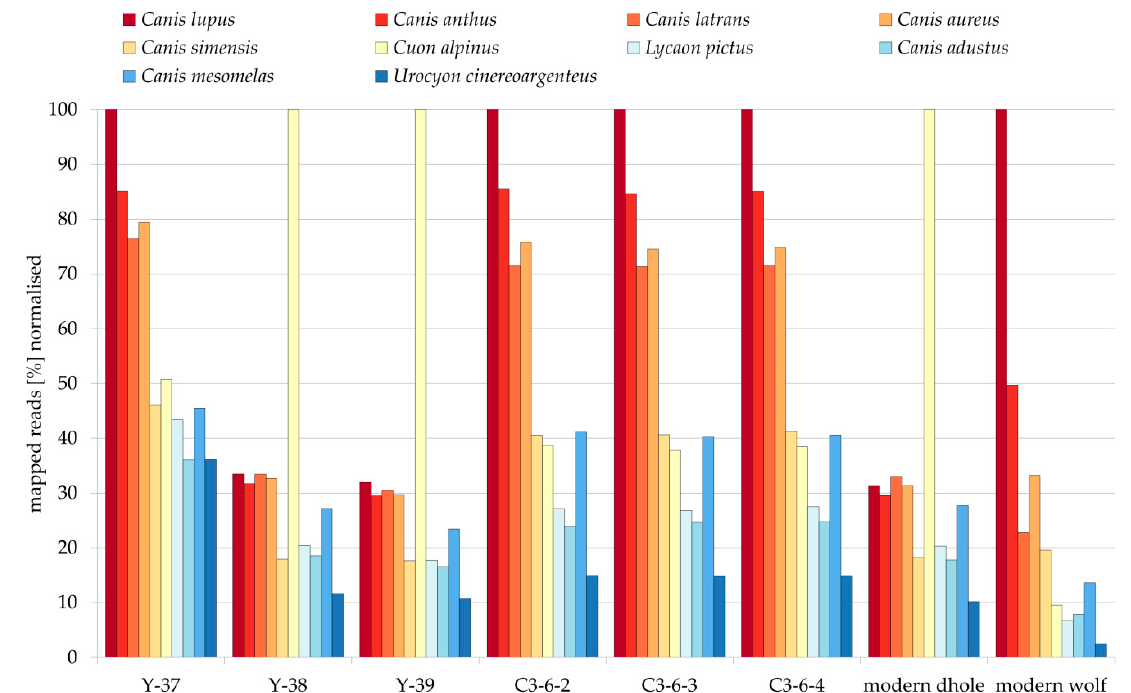
Figure 1. Percentage of reads mapping to various canid mitochondrial genomes for six ancient potential dhole samples, one modern dhole, and one modern gray wolf sample. Percentages were normalized to the highest number of mapping reads that was achieved for a canid mitochondrial genome (bars reaching 100%).